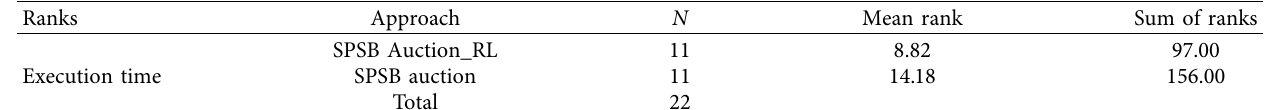
Figure 5: Te average execution time for diferent approaches. Table 6: Ranks assigned to each method in the Mann ‒ Whitney U test.